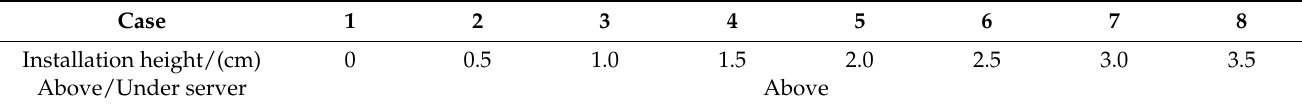
Table 3. The distance analysed of upper mounted HPEs between the servers.